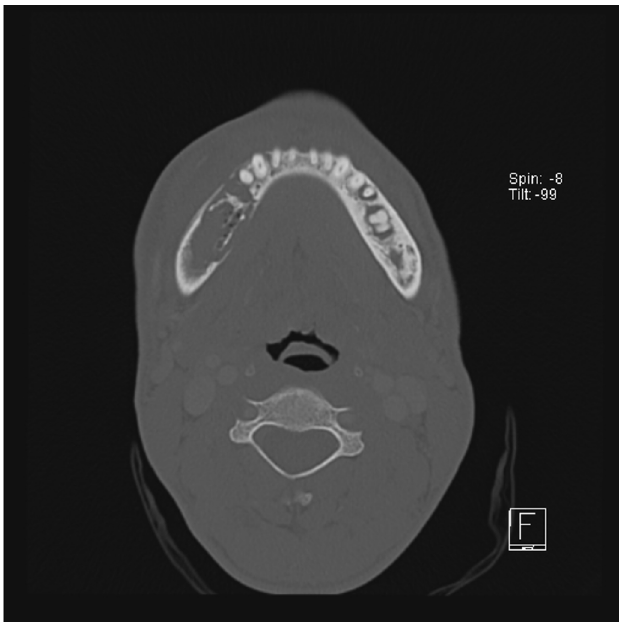
Fig. 2. Computed tomography: large sequestrum of alveolar bone extending from the lower right fi rst molar (LR6) to the fi rst premolar